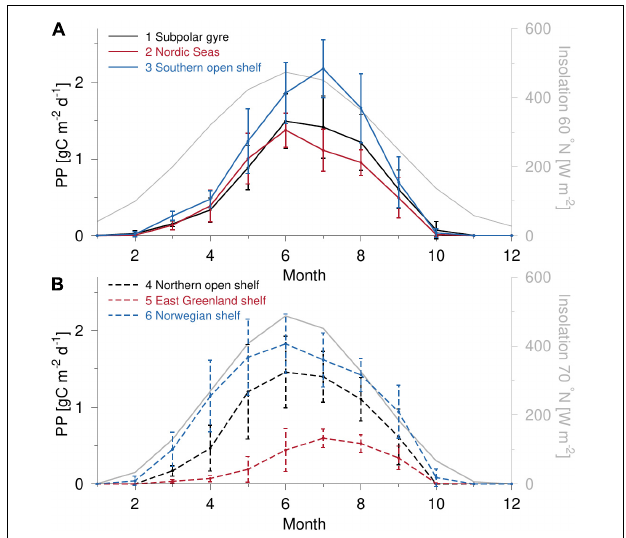
FIGURE 4 | Monthly averaged PP during the 2003–2013 period for (A) subdomain 1–3 and (B) 4–6 (average values with shown standard deviation). Monthly averaged insolation at the top of the atmosphere is shown for (A) 60 ◦ N and (B) 70 ◦ N (gray, right axis).